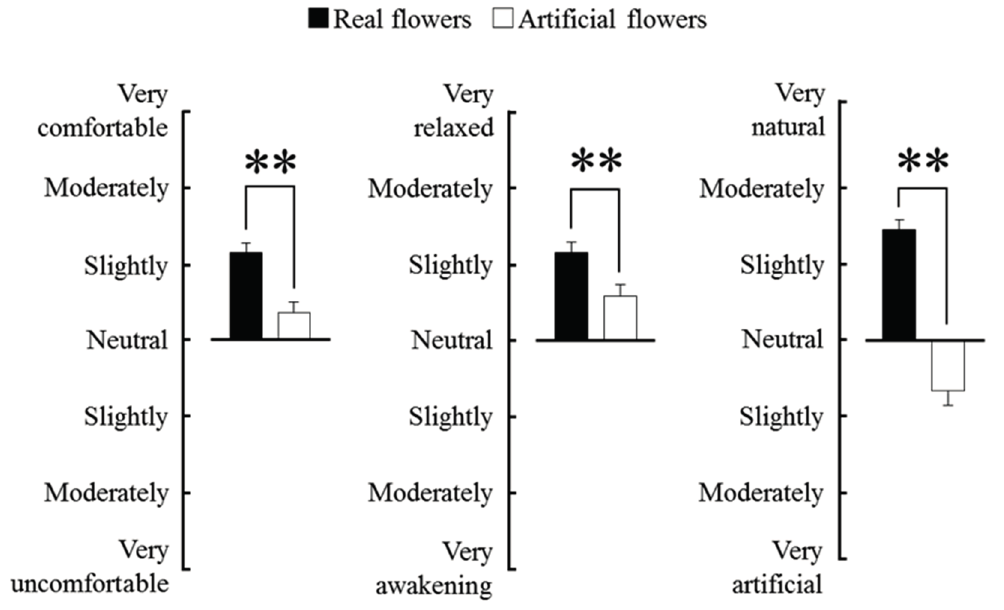
Figure 3. Comparison of the subjective scoring for comfortable, relaxed, and natural feelings between real and artificial flowers. n = 40, mean ± SE. ** p < 0.01, determined by Wilcoxon signed-rank test